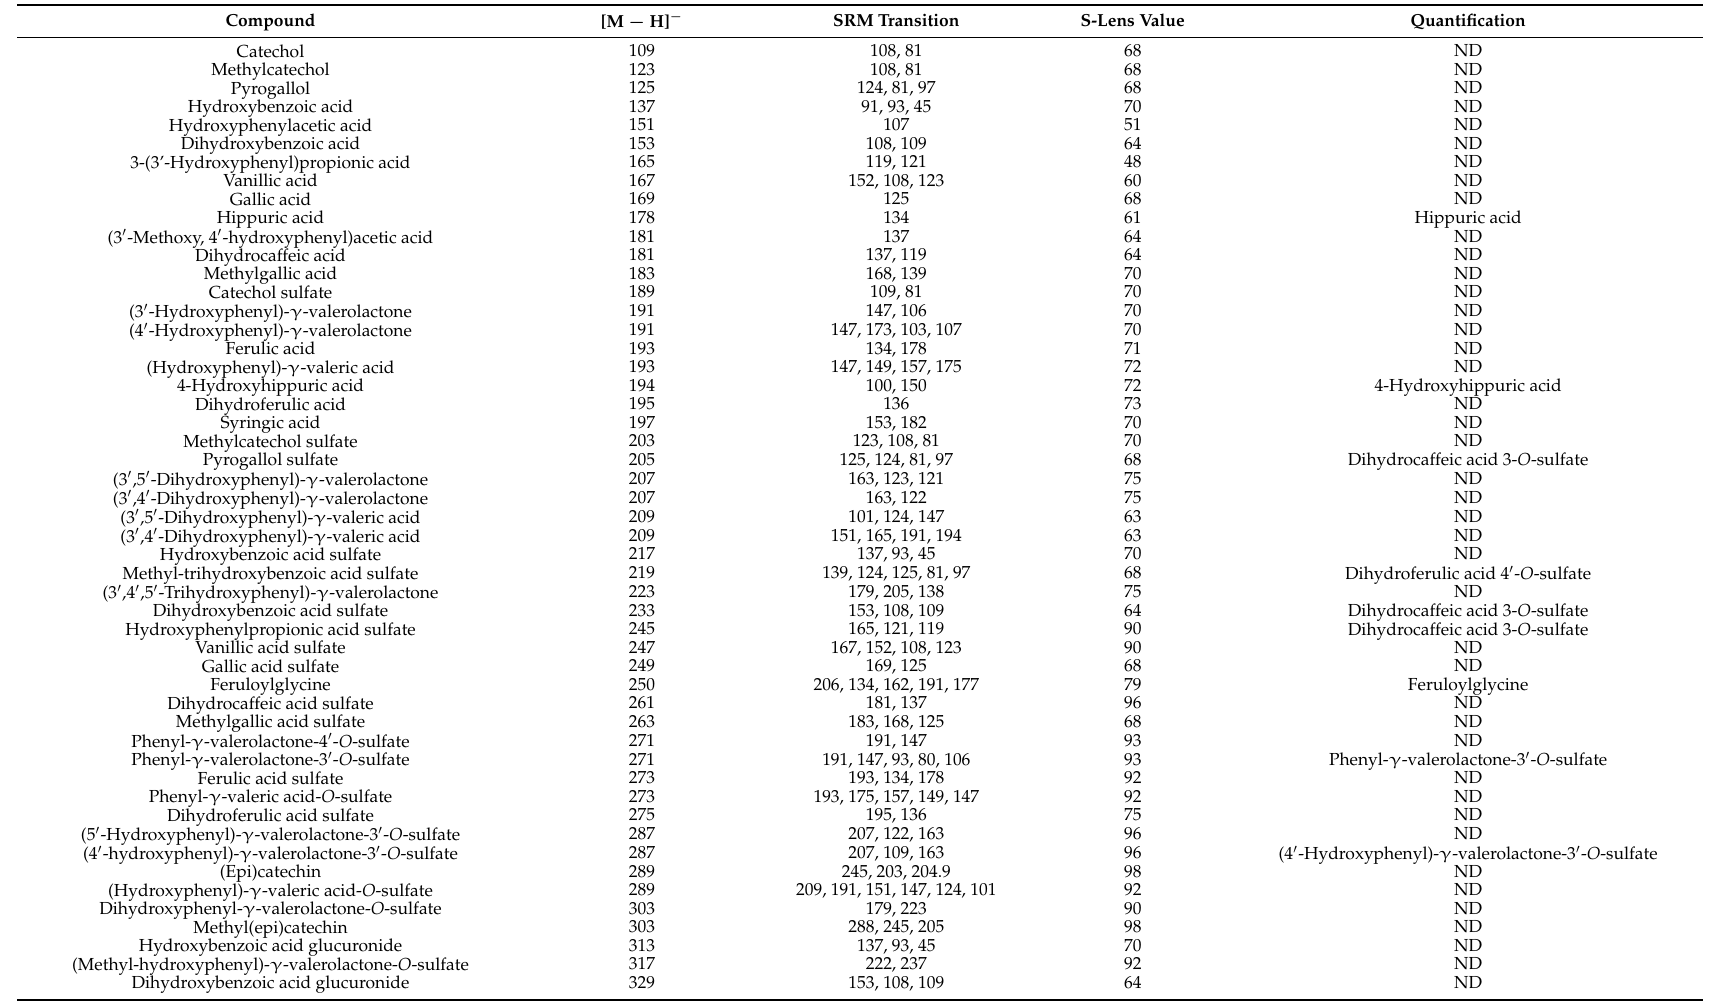
Table 1. Spectrometric characteristics of the 92 monitored compounds, and standard compounds used for quantification of the 20 identified metabolites. Legend: SRM: selective reaction monitoring; ND: not